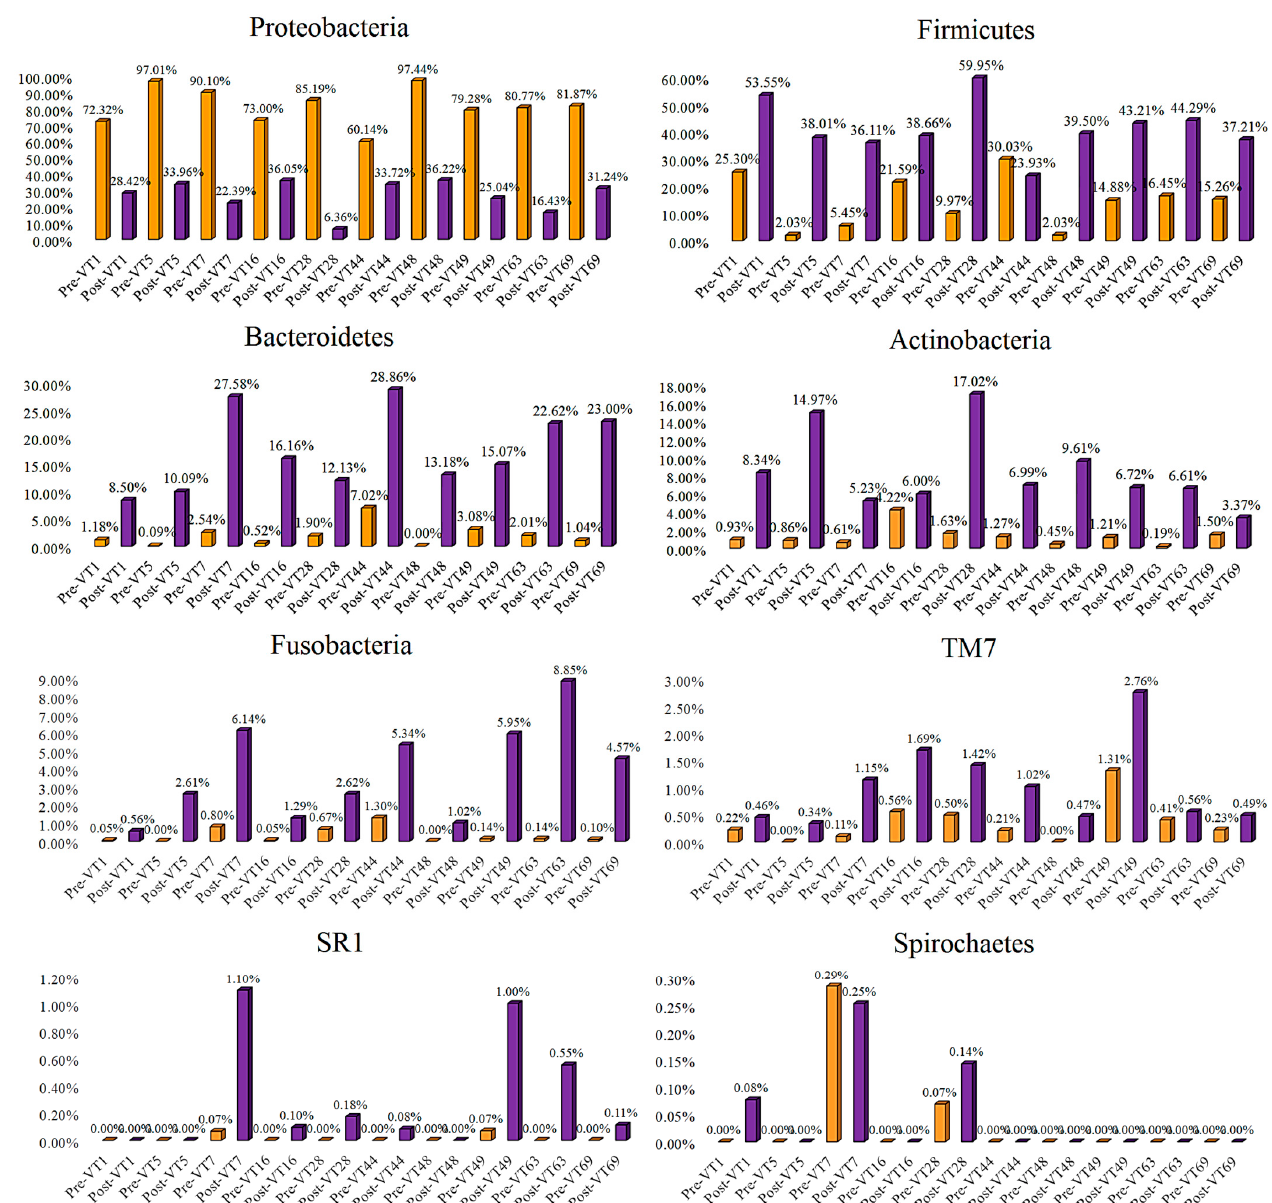
Figure 5. The abundant phyla of the G2 (mouthwash formulation II) samples were compared before and after mouthwash to identify the formulation’s efficacy. Purple and orange bars indicate the pre- and post-treatment samples, respectively.